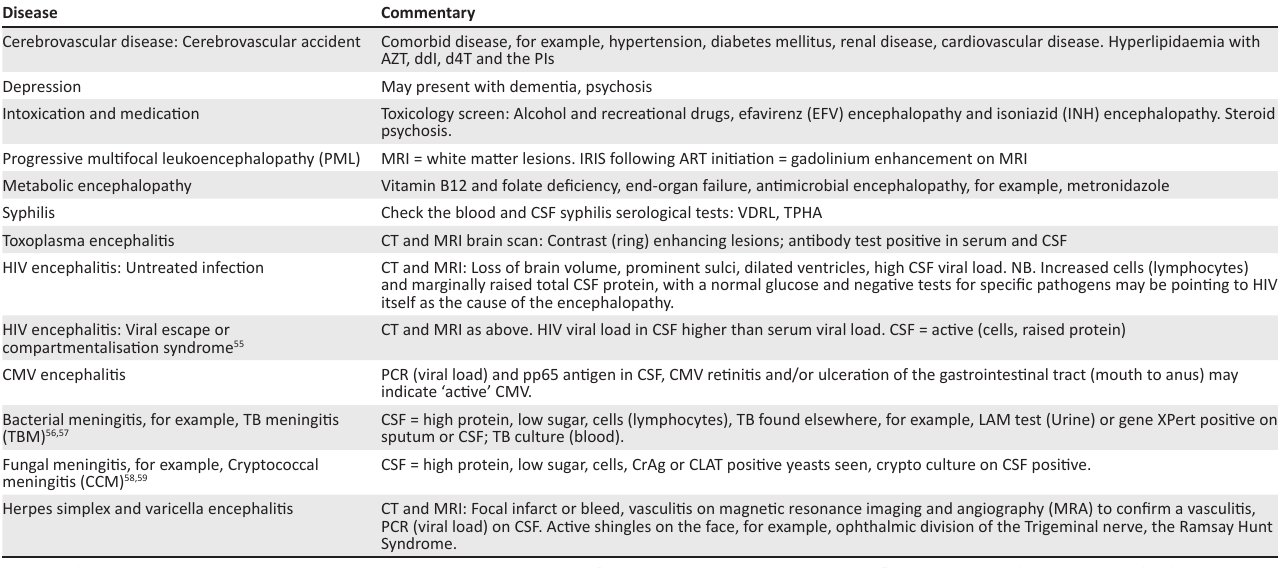
TABLE 3: HIV+ concurrent disease and commentary. Disease